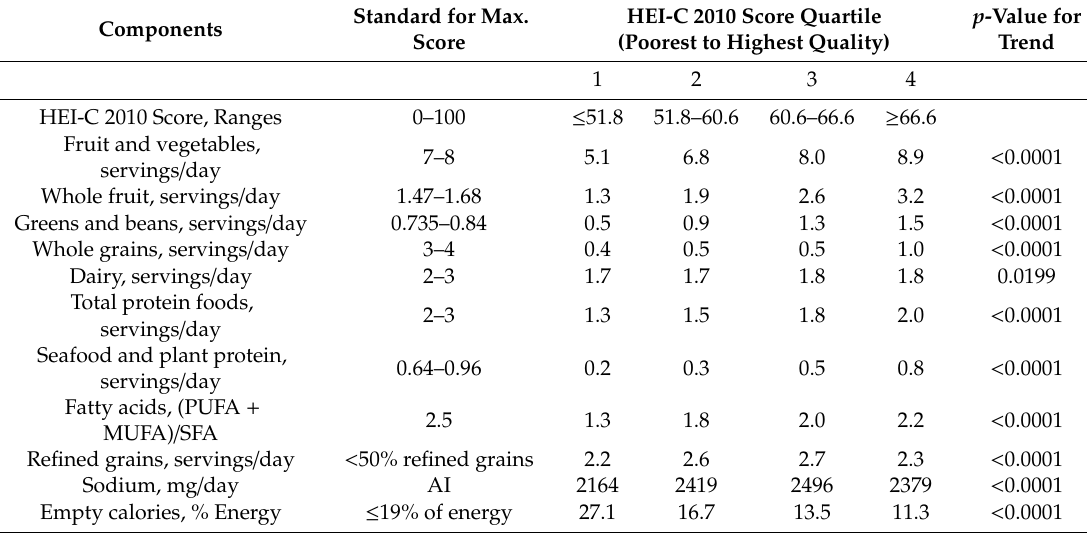
Table 2. Mean values of Healthy Eating Index 2010 (HEI-C) individual components and overall score presented by HEI-C quartile among diet sample ( n = 6087).